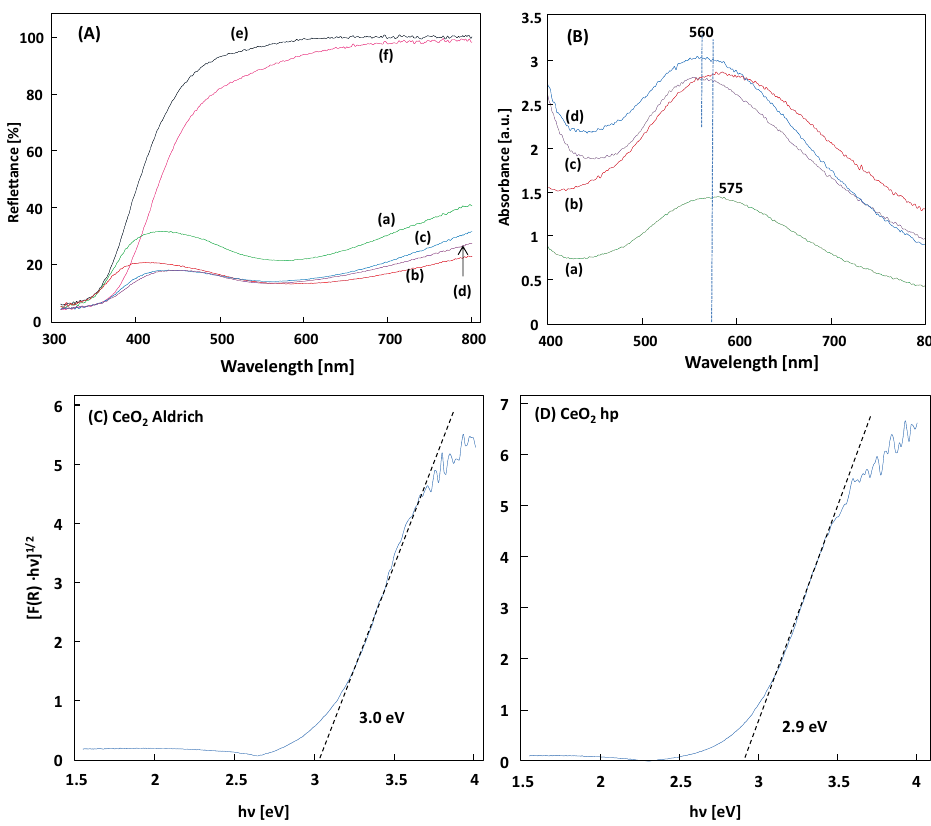
Figure 7. ( A ) DRS and ( B ) absorption spectra of the samples: (a) 1%Au/CeO 2 A; (b) 3%Au/CeO 2 A; (c) 1%Au/CeO 2 hp; (d) 3%Au/CeO 2 hp; (e) CeO 2 A; (f) CeO 2 hp and ( C , D ) Tauc plot of CeO 2 A and CeO 2 hp samples, respectively.